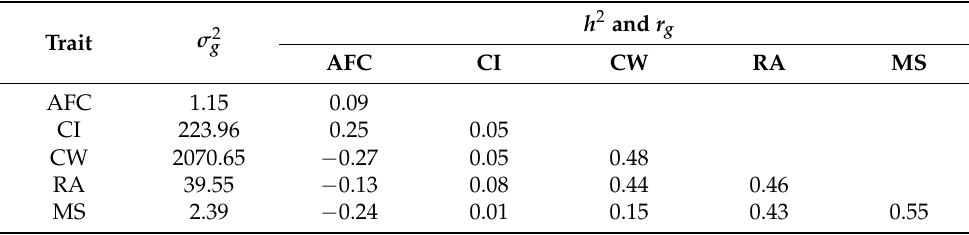
Table 3. Values of additive genetic variance ( σ 2 g ), heritability ( h 2 , diagonal), and genetic correlation ( r g , below diagonal), used for selection simulation 1 .